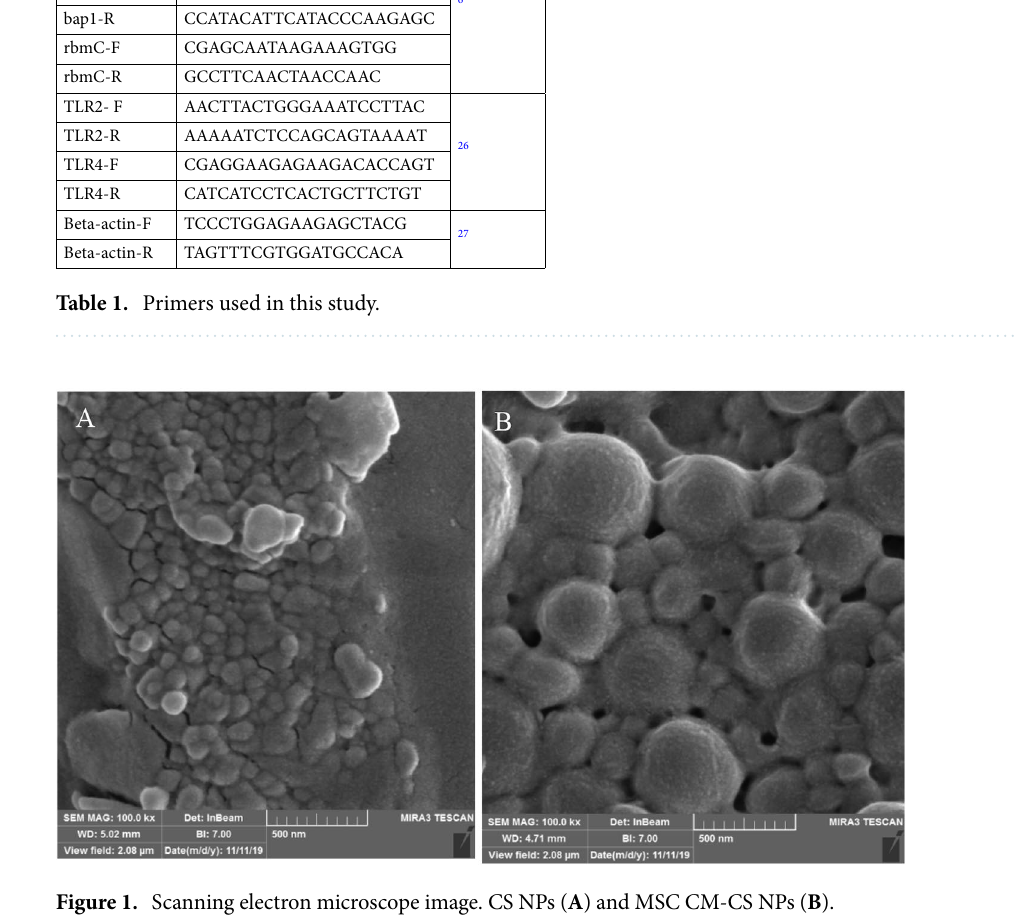
Figure 1. Scanning electron microscope image. CS NPs ( A ) and MSC CM-CS NPs ( B